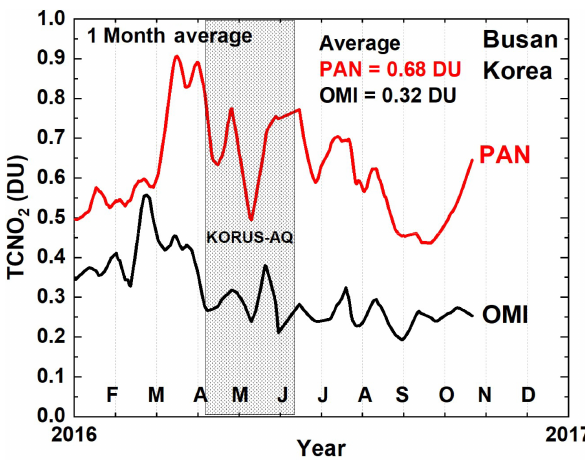
Figure 2. Monthly average values of TCNO 2 for OMI and PAN- DORA at OMI overpass